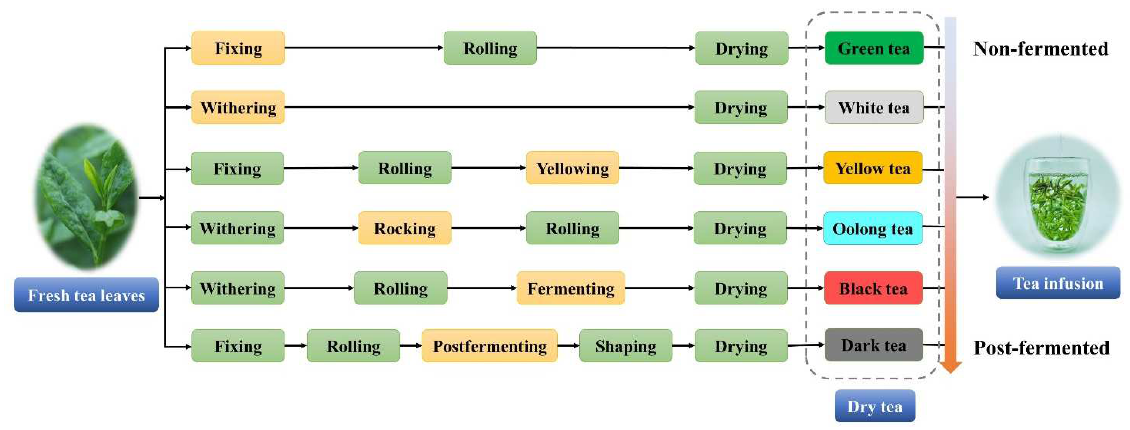
Figure 1. Manufacturing processes of six major tea categories: from fresh tea leaves to infusion. The acceptance and preference of tea by people from different countries and nation- alities are largely related to its beneficial effects on health. Tea has been regarded as a traditional Chinese medicine that can improve or prevent various diseases since ancient times. Tea is rich in polyphenols, the content of polyphenols in fresh tea leaves is generally 18% to 36% (dry weight), with strong anti-inflammatory, antioxidant, and anti-mutation